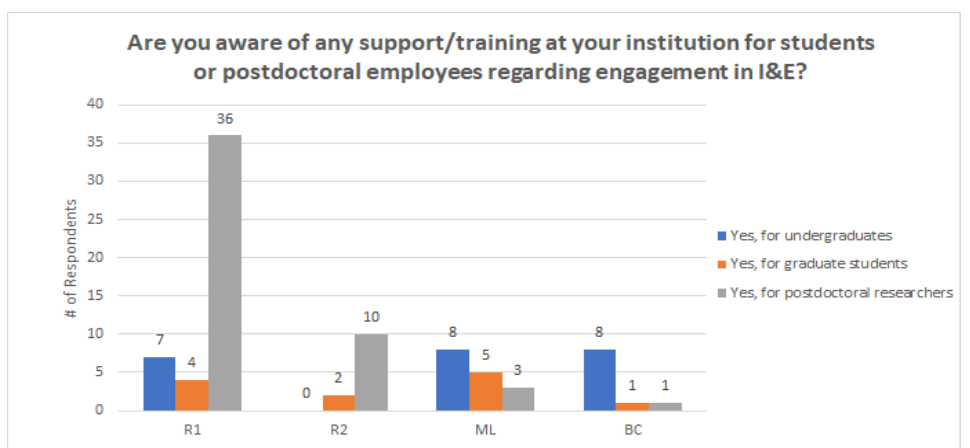
Figure 16. Comparison of institution type responses of awareness of support or training at their institution that specifically targets faculty engaging in I&E or underrepresented tenure-line faculty groups (e.g., women faculty, faculty of color) engaging in I&E.